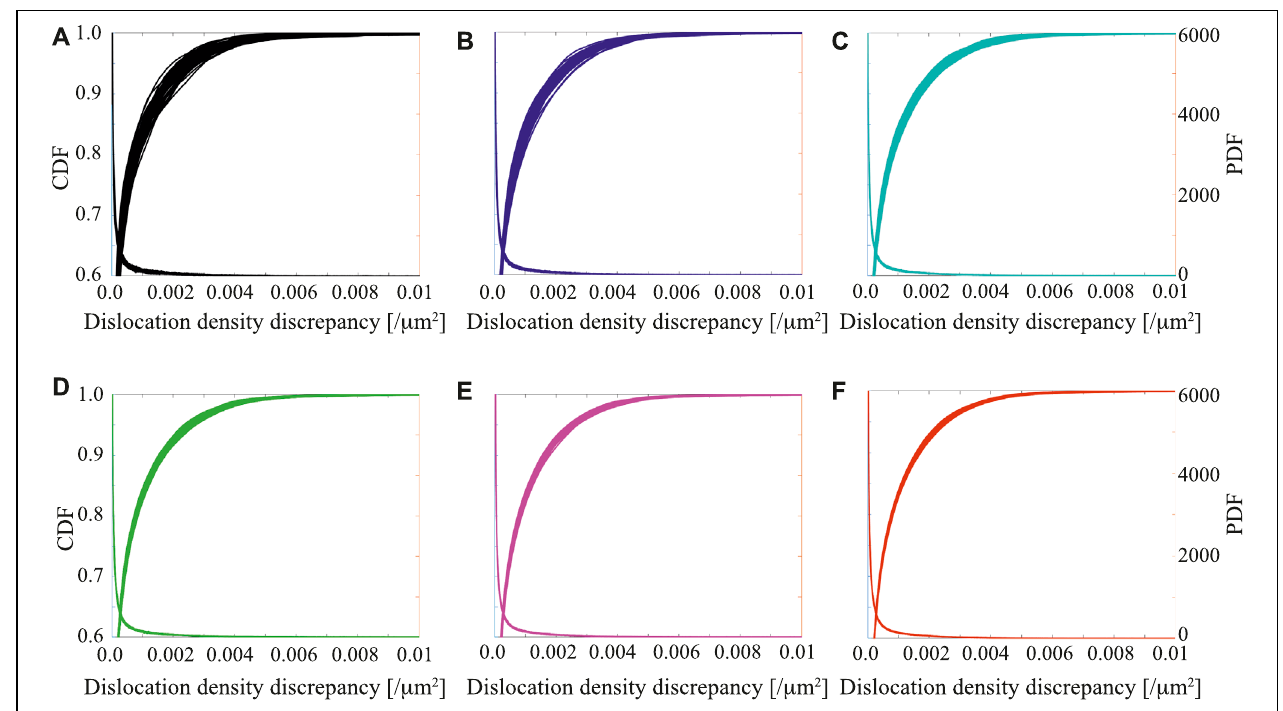
FIGURE 4 | Variability in the cumulative and probability distributions of D 3 as a function of ensemble size (A) 100 SVEs, (B) 250 SVEs, (C) 500 SVEs, (D) 750 SVEs, (E) 1,000 SVEs and (F) 2,000 SVEs.